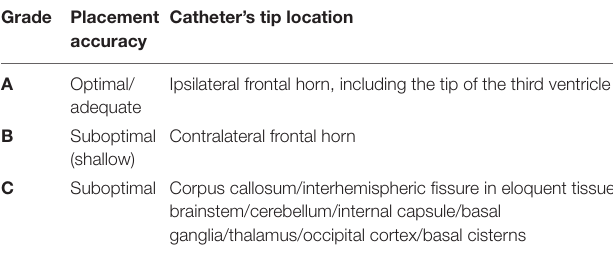
TABLE 1 | Kakarla grading system for ventricular catheter tip